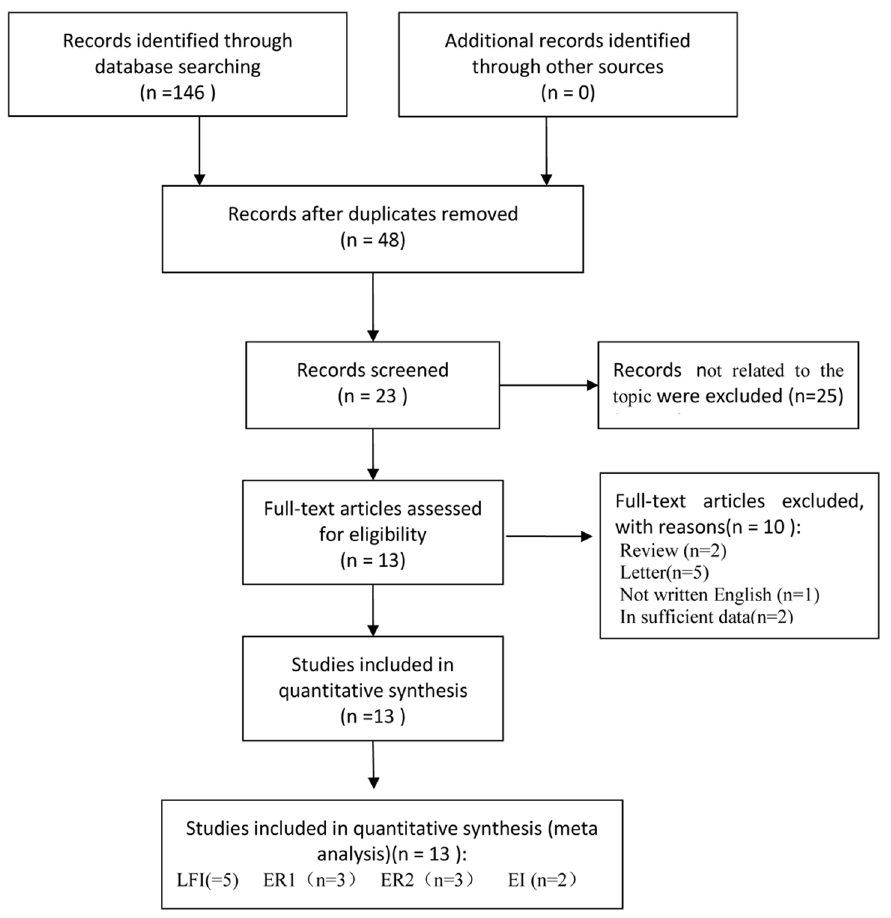
Fig. 1. Flow diagram of search results and study